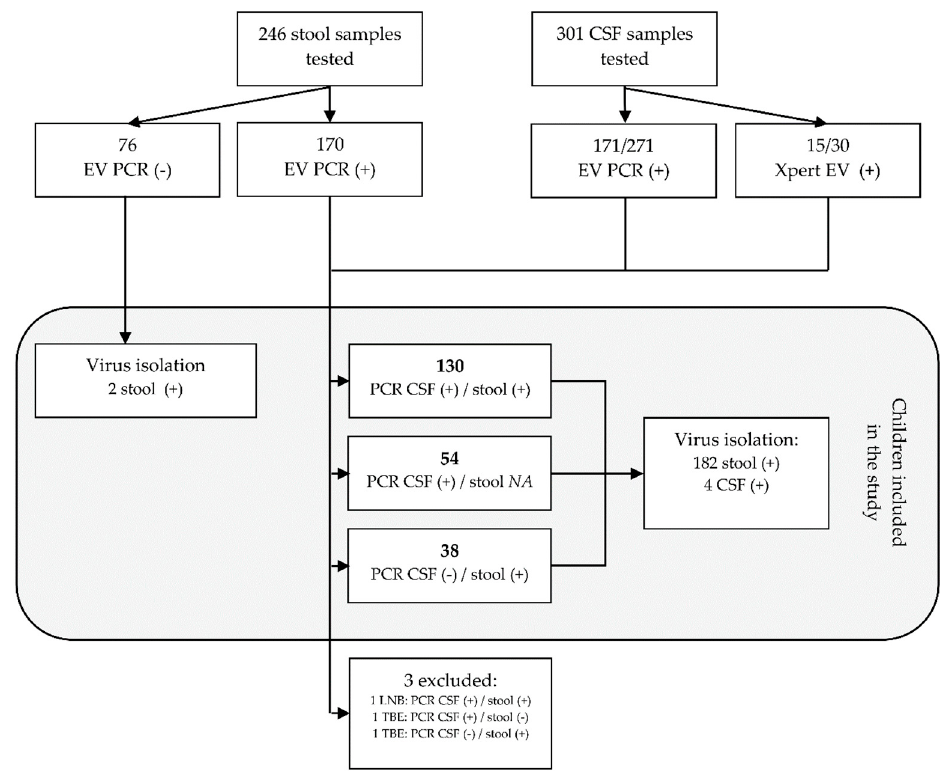
Figure 1. The flowchart representing the process of selecting children for the study. A total of 345 children with signs of meningitis of encephalitis were tested for enteroviruses. Of those, 224 were diagnosed with central nervous system (CNS) infection caused by enteroviruses. Abbreviations: EV PCR, diagnostic pan-enterovirus RT-PCR; virus isolation, virus isolation in cell cultures; CSF, cerebrospinal fluid; LNB, Lyme neuroborreliosis; TBE, tick-borne encephalitis; NA, not available for EV PCR.